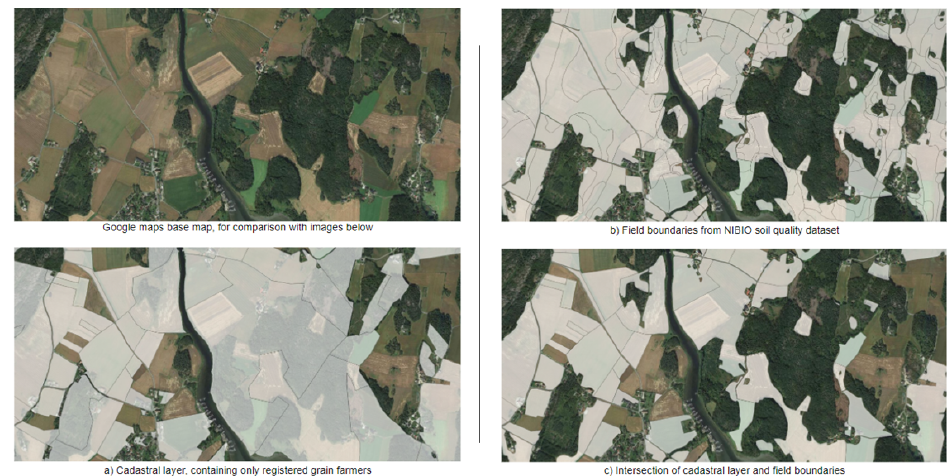
Figure 2. Visualisation of the geographical layers, overlaid on a satellite